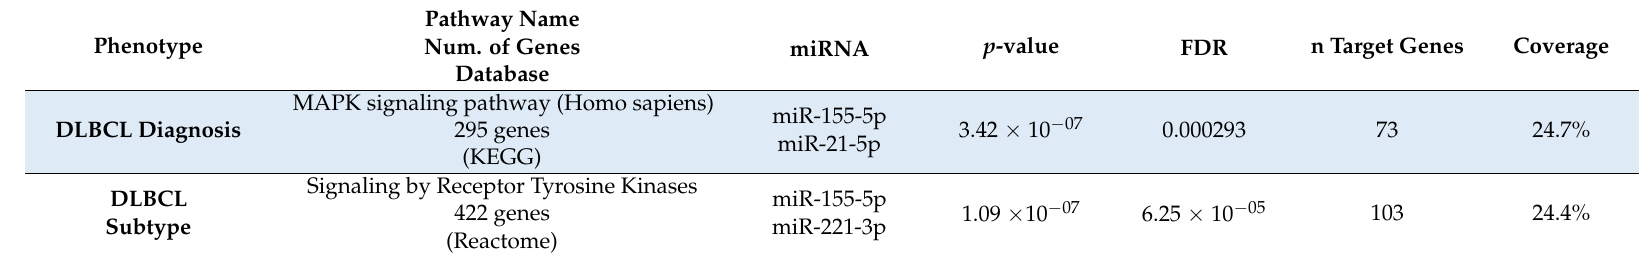
Table 4. Coverage of DLBCL related pathway with miRNA predicted